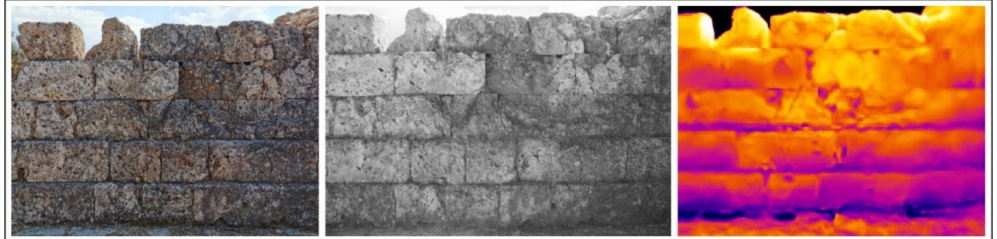
Figure 17. Reflectance images captured at the archaeological site of Lepreum: (from left to right) visible-spectrum, near- infrared, and a thermal-infrared image.